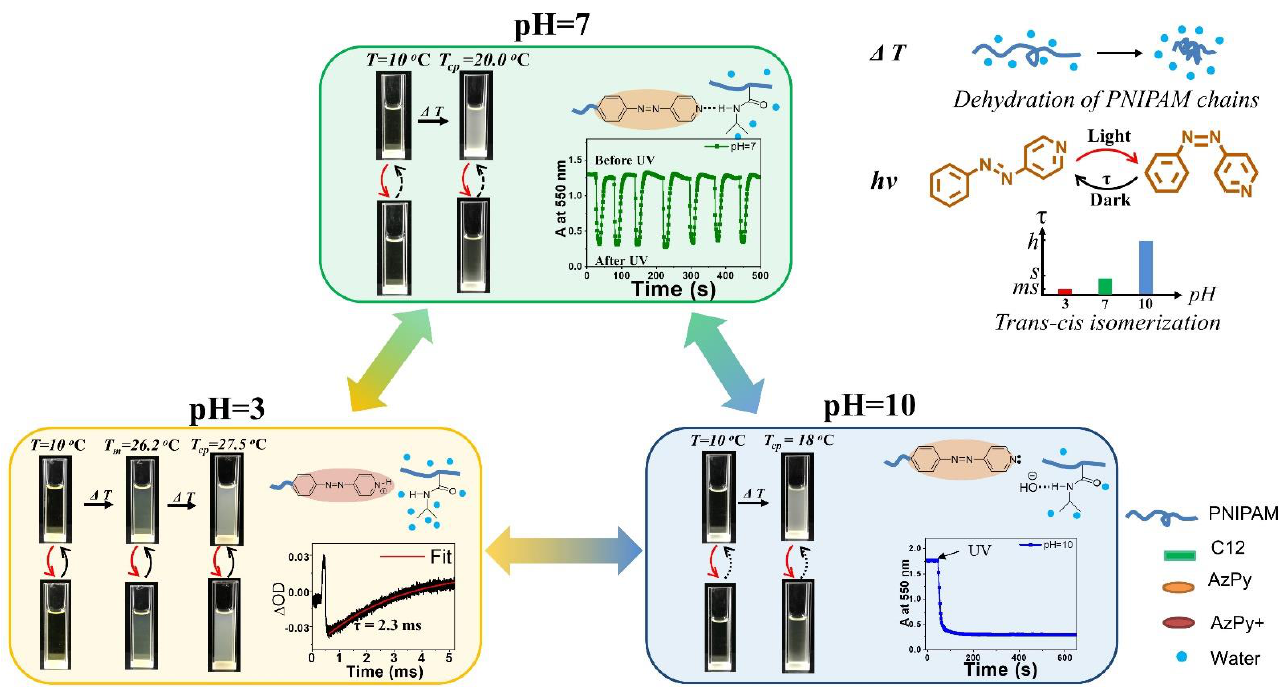
Figure 14. pH − and UV − induced thermoresponsive properties of C12 − PN − AzPy (the temperatures correspond to a polymer of M n ~7000 g mol − 1 , ∆ OD: difference in the optical density before and after irradiation). Reprinted with permission from [75,79]. Copyright 2019 and 2020, Royal Society of Chemistry.